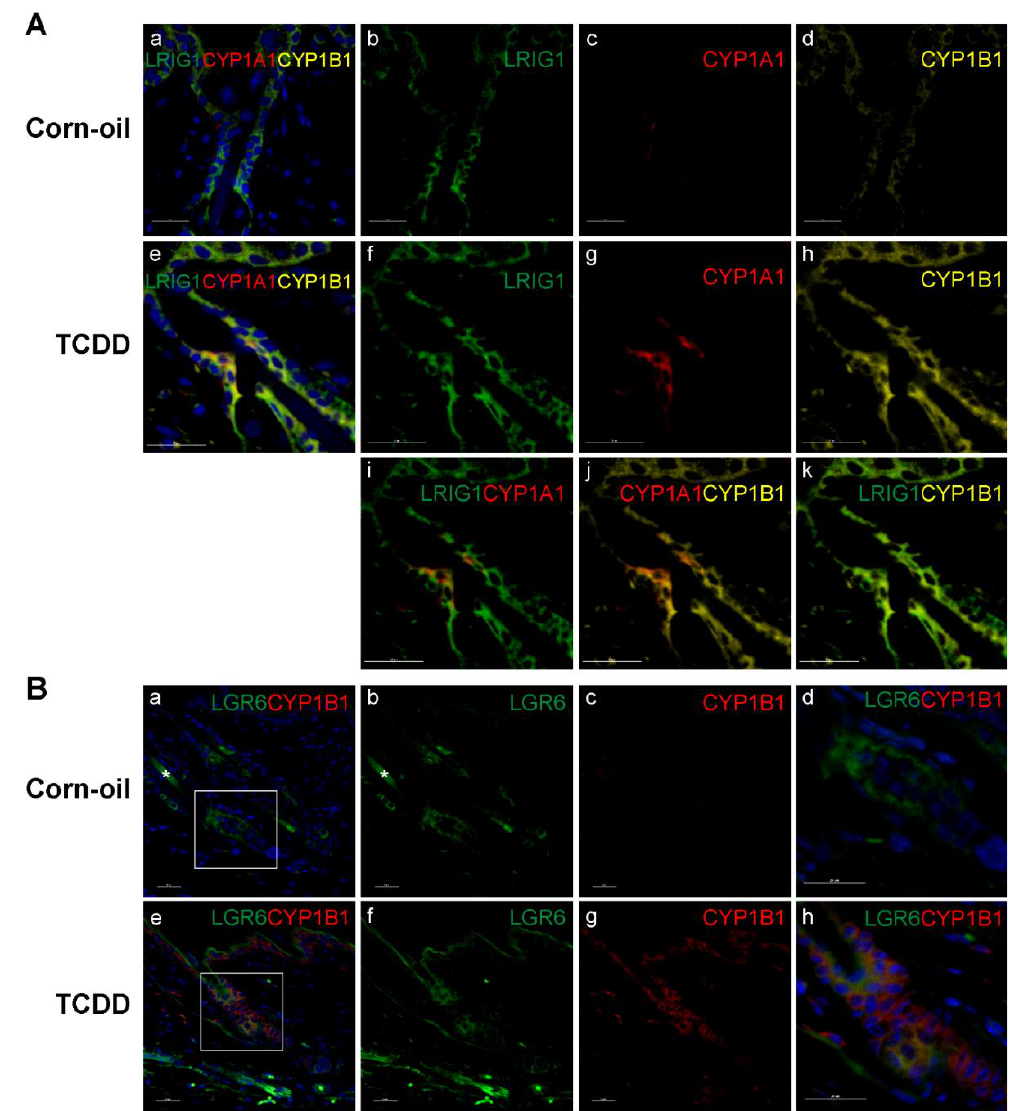
Figure 7. Expression of skin stem cell progenitor markers and AHR biomarkers in skin. Time-mated mice were treated by gavage with either corn-oil or TCDD (5 µ g/kg bw) and pups were analyzed for specific localization of response to TCDD. Corn-oil- or TCDD-exposed skin samples at P21 were labeled with antibodies as indicated. DAPI (blue) was used to stain nuclei. ( A ) CYP1A1, CYP1B1, and LRIG1 expression in corn-oil- ( a – d ) and TCDD- ( e – k ) treated skin samples, as indicated. ( B ) CYP1B1 and LGR6 expression in corn-oil- ( a – d ) and TCDD- ( e – h ) treated skin, as indicated. Boxed areas in ( a , e ) are shown at higher magnification in ( d , h ), respectively. Scalebar = 25 µ m. Abbreviations: AHR, aryl hydrocarbon receptor; TCDD, 2,3,7,8-tetrachlorodibenzo- p -dioxin; bw, body weight; P, postnatal day; DAPI, 4 (cid:48) ,6-diamidino-2-phenylindole; CYP1A1, cytochrome P4501A1; CYP1B1, cytochrome P4501B1; LRIG1, Leucine-rich repeats and immunoglobulin-like domains protein 1; LGR6, Leucine-Rich Repeat Containing G Protein-Coupled Receptor